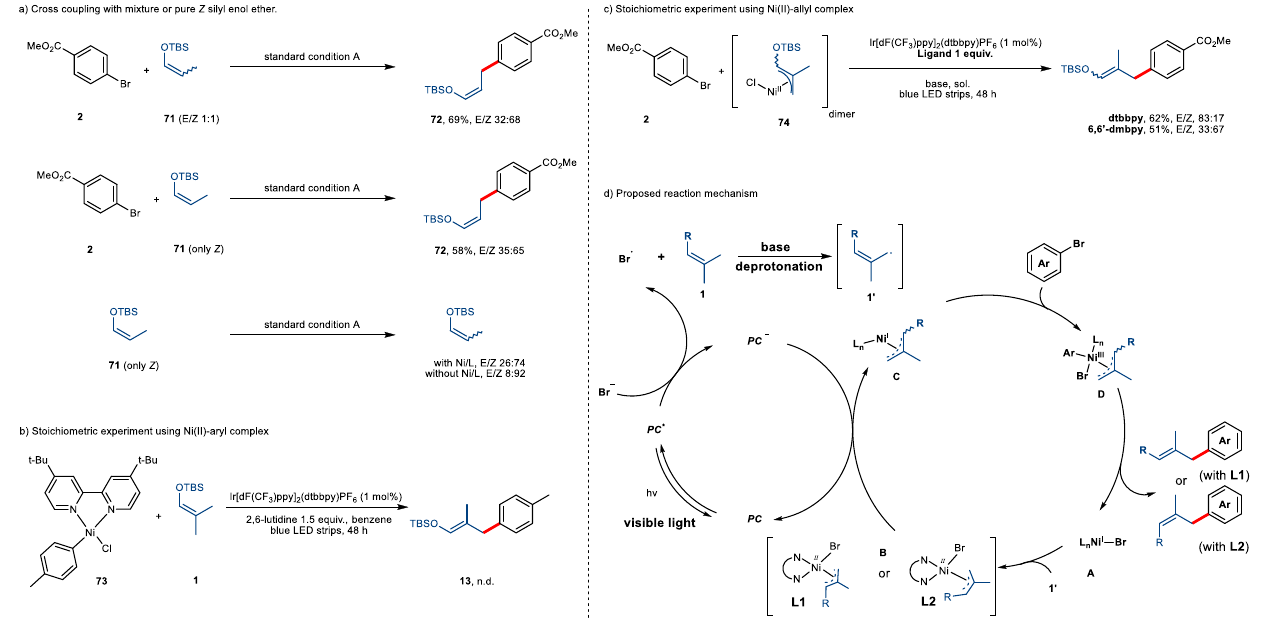
Fig. 6 | A proposedmechanismbased onexperimentalinvestigation. a Experimentssupporting the intermediacy of a nickel-allyl species. b Stoichiometric studywith Ni(II)-Aryl complex. c Stoichiometric study with Ni(II)-Allyl complex. d Proposed reaction